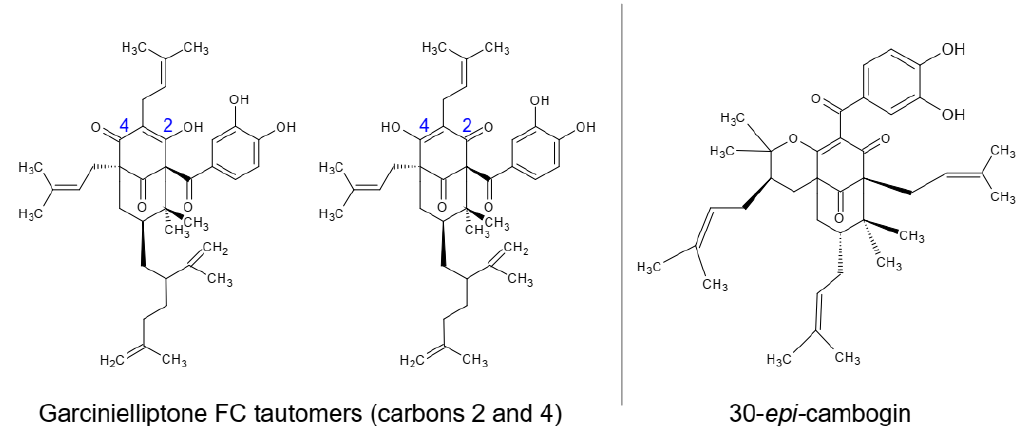
Figure 1. Identified prenylated benzophenones on epicarp (garcinielliptone FC tautomers) and mesocarp (30- epi -cambogin). Table 2. Multivariate analysis correlation matrix of the response variables screened. Mesocarp Samples Epicarp